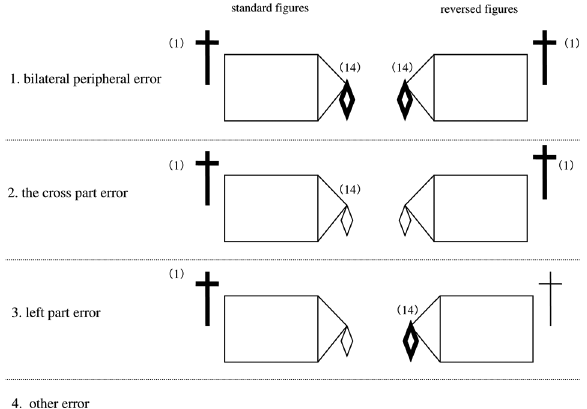
Figure 1. Illustrations of the RCFT figures emphasizing the unit 1 and 14.